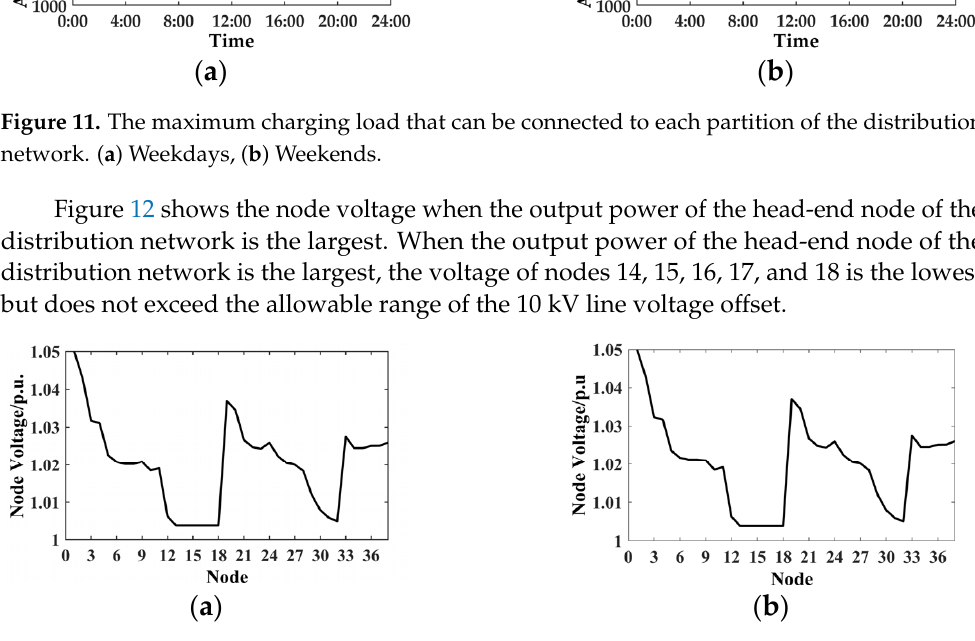
Figure 12. Node voltage at the maximum output power of node 1 of the distribution network. ( a )